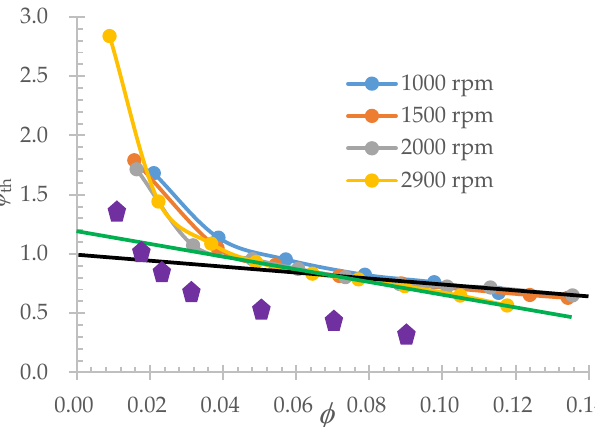
Figure 9. Theoretical head coe ffi cient versus flow coe ffi cient for four di ff erent rotational speeds (purple diamond symbols are extracted from the results published by Yin [6] for 2900